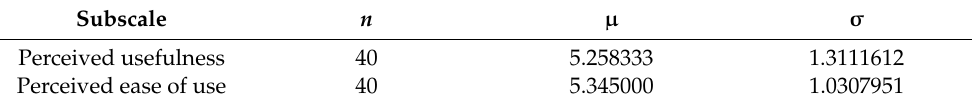
Table 10. Mean ( µ ) and standard deviation ( σ ) value of TAM.